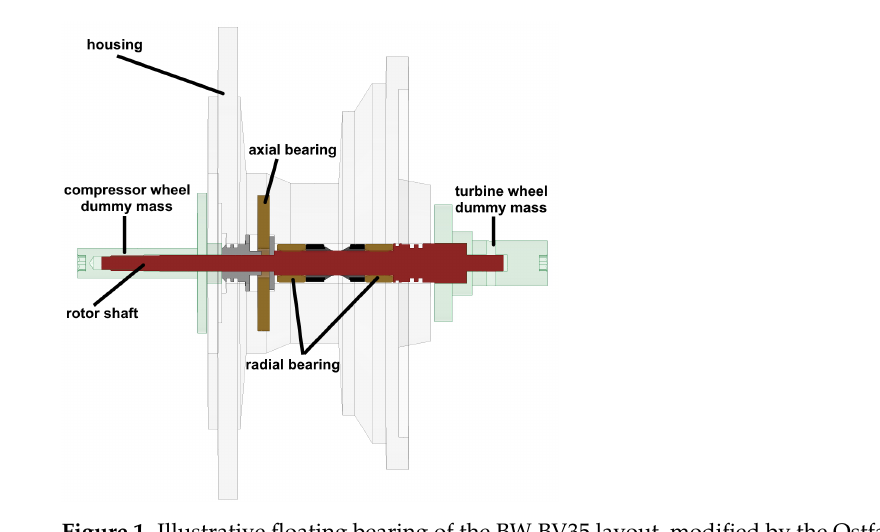
Figure 1. Illustrative floating bearing of the BW BV35 layout, modified by the Ostfalia.